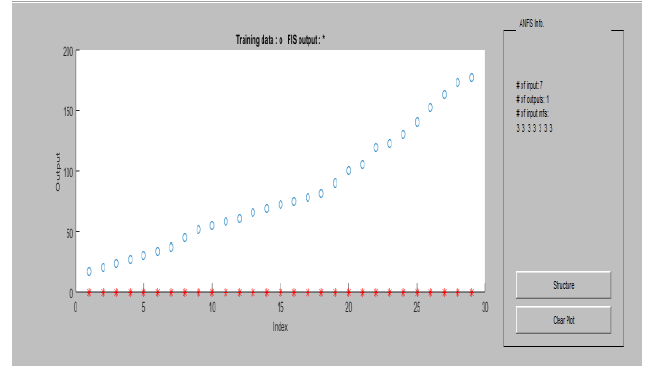
Figure 12. Dataset